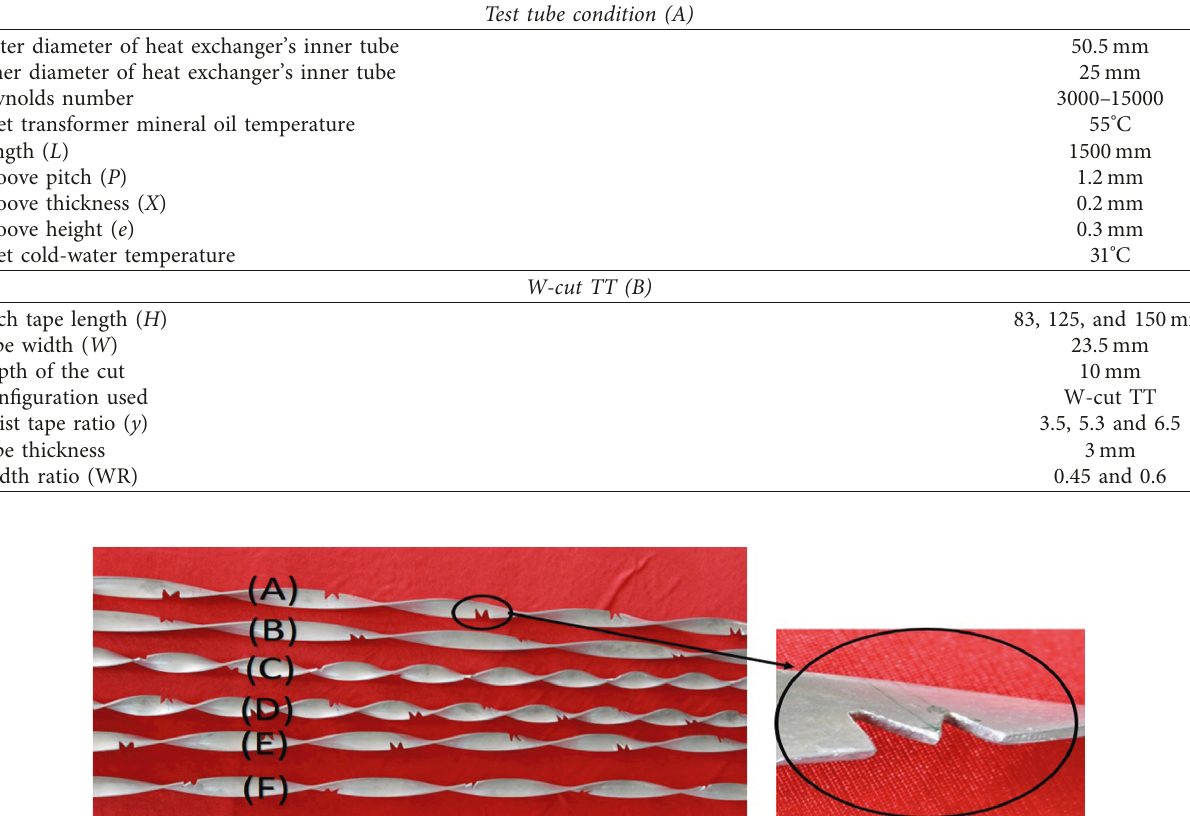
Figure 2: Cut section of internally grooved test section: (a) grooved copper pipe, (b) 3D model of grooved pipe, (c) schematic of groove. Table 1: Experimental details.